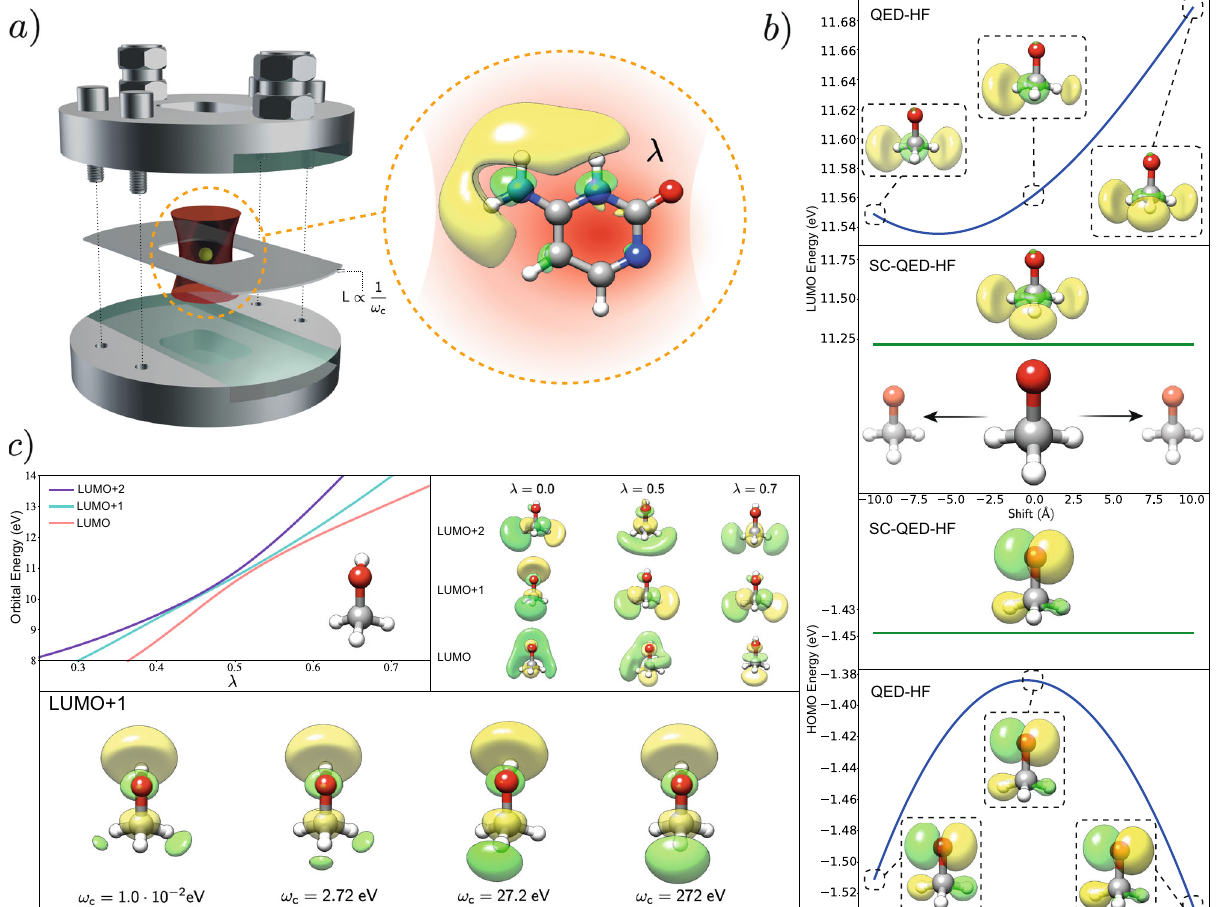
Fig. 1 Orbital properties in optical cavities. a Pictorial representation of an optical cavity with an injection input, the coated glasses, and a spacer to regulate the distance between the mirrors. The frequency of the cavity fi elds is proportional to the inverse of the distance between the two mirrors. The lambda parameter quanti fi es the strength of the light-matter coupling. The cavity picture is based on a video realized by the Ebbesen group. b Origin invariance of the SC-QED-HF orbitals compared with the origin dependence of QED-HF orbitals. If the methoxy ion is displaced in space, both the orbital energies and the orbital shapes changes for QED-HF orbitals, while the SC-QED-HF orbitals remain unaltered. c Orbital modi fi cations due to changes in the cavity parameters. Changing the cavity parameters (frequency and coupling) the electronic ground state and therefore the molecular orbitals are changed. Particularly, we show that an avoided crossing like situation can be observed among